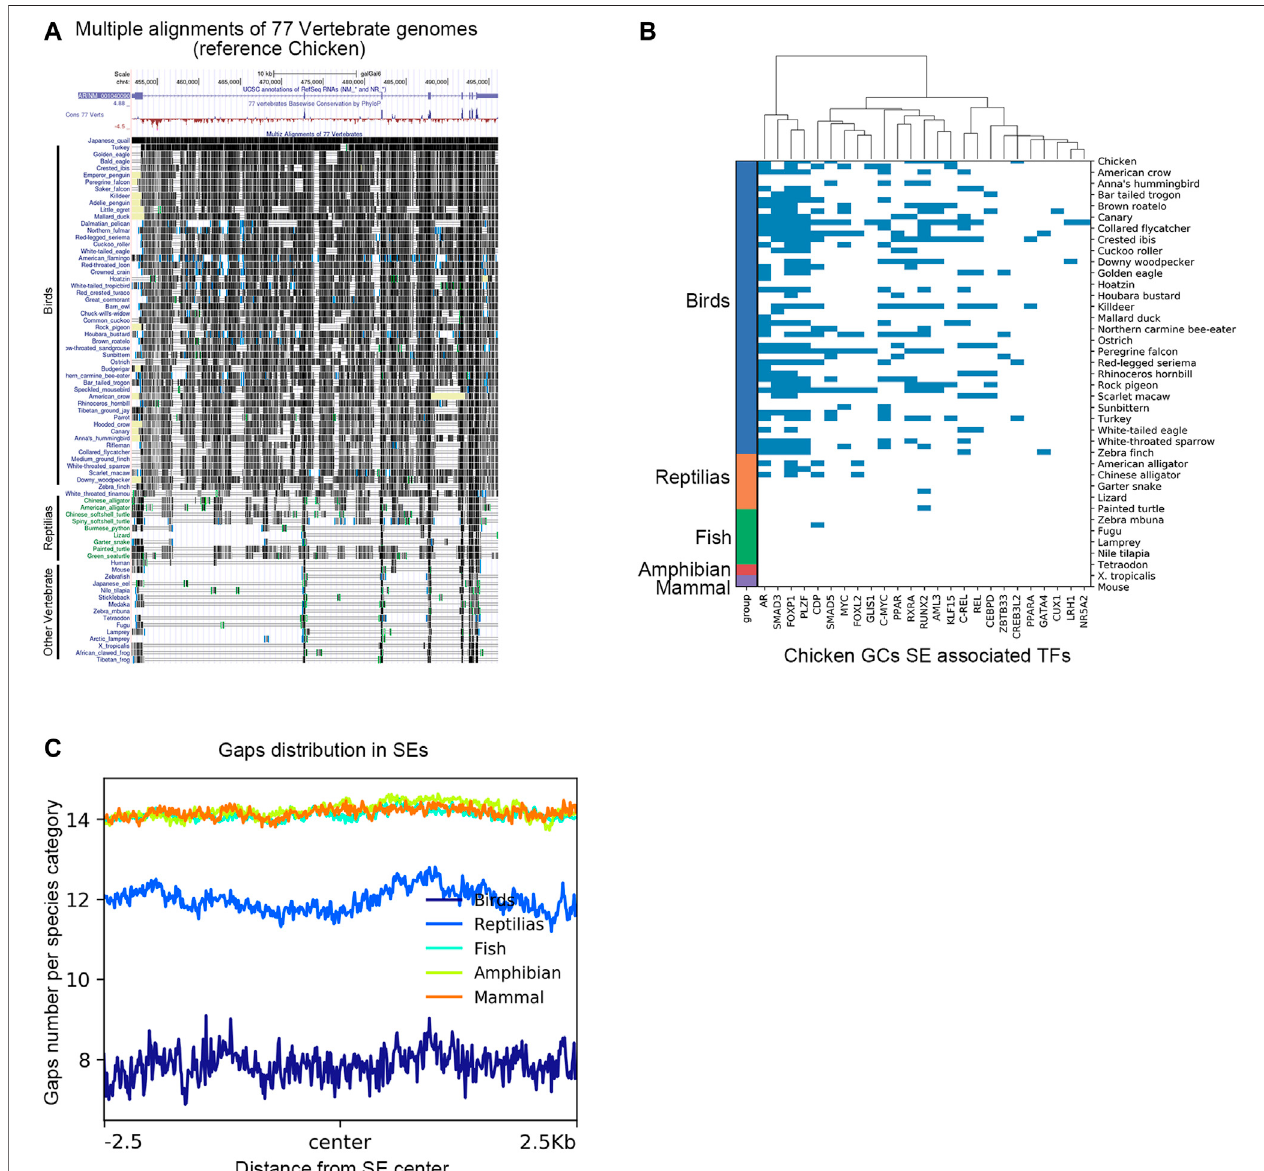
FIGURE 7 | The AR super-enhancer genomic region in chicken poGCs is speci fi c to birds. (A) Multiple alignments of the 77 vertebrate genomes in the UCSC Genome Browser at the AR locus using chickens as a reference. (B) Binding pro fi le of candidate TFs screened by chicken poGC super-enhancers in genomic regions homologous to the chicken AR super-enhancer in 77 species. (C) Gaps distribution in genomic regions homologous to chicken poGC super-enhancers across 77 species.